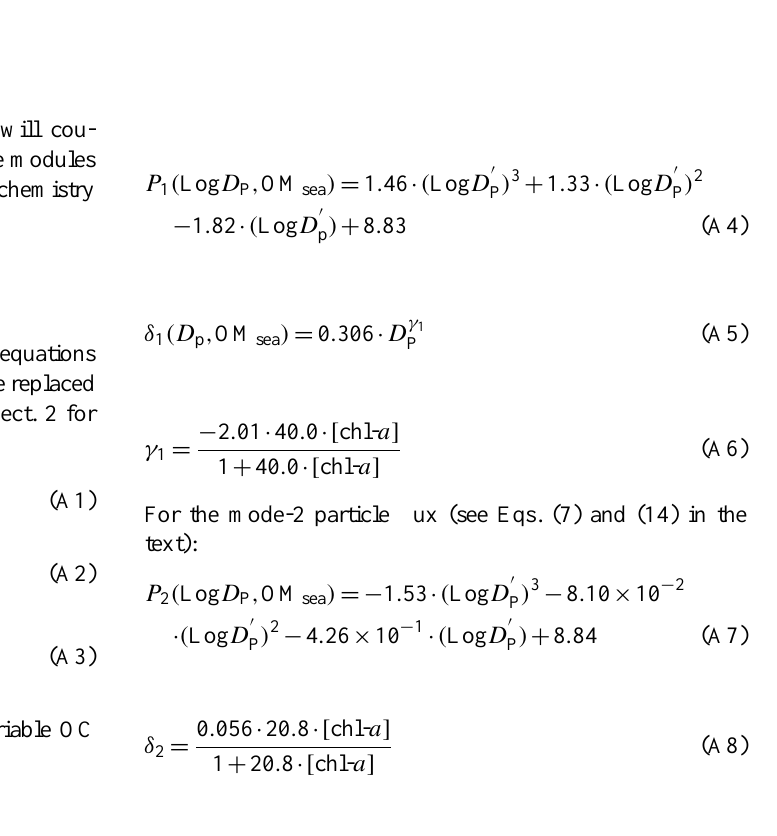
Zutic and Legovic (1990) N. Adriatic